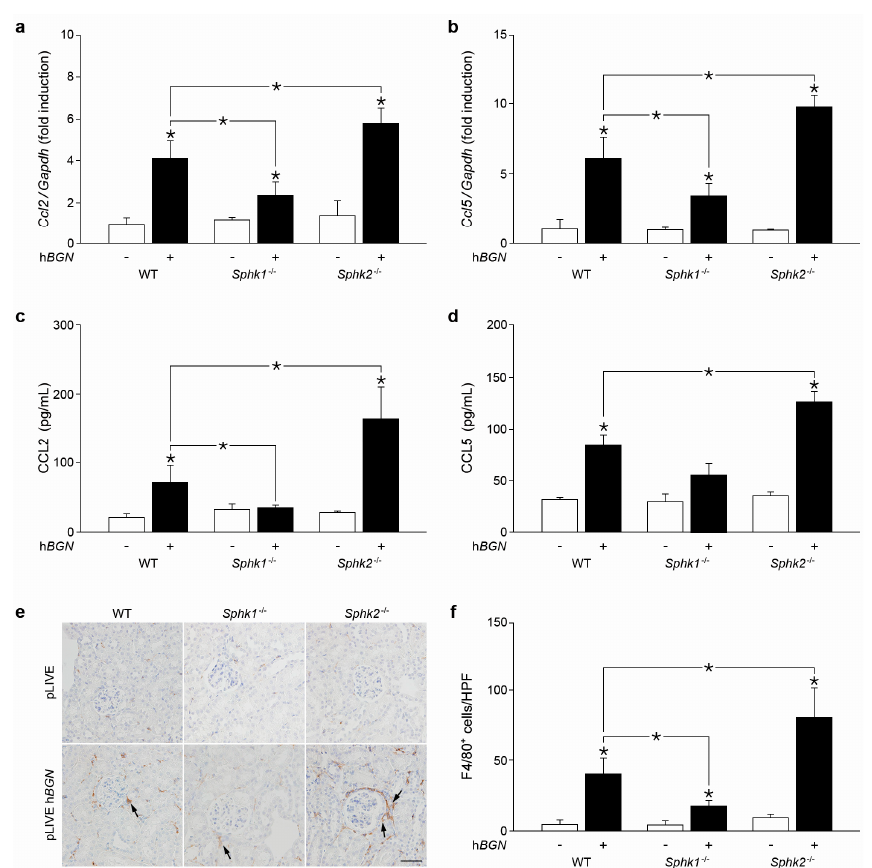
Figure 6. Biglycan induces Ccl2 and Ccl5 expression through SphK1 leading to renal recruitment of macrophages. ( a , b ) qPCR analysis of renal: ( a ) Ccl2; and ( b ) Ccl5 mRNA expression levels in pLIVE-h BGN and pLIVE (control) WT, Sphk1 − / − and Sphk2 − / − mice, three days of transfection. mRNA expression was normalized to Gapdh and given as fold induction of pLIVE-treated WT controls. ( c,d ) Plasma levels of: CCL2 ( c ); and CCL5 ( d ) in WT, Sphk1 − / − , and Sphk2 − / − mice, 3 days of transfection. ( e ) Immunohistochemical staining of the F4/80 macrophage marker (brown, depicted by arrows) in renal sections of WT, Sphk1 − / − , and Sphk2 − / − mice after injection of pLIVE-h BGN or pLIVE control, three days of transfection. Scale bar: 50 μ m. ( f ) Quantification of F4/80 + cells given as cell count per high-power field (HPF). Data are expressed as means ± SD. n = 3 mice per group; * p < 0.05